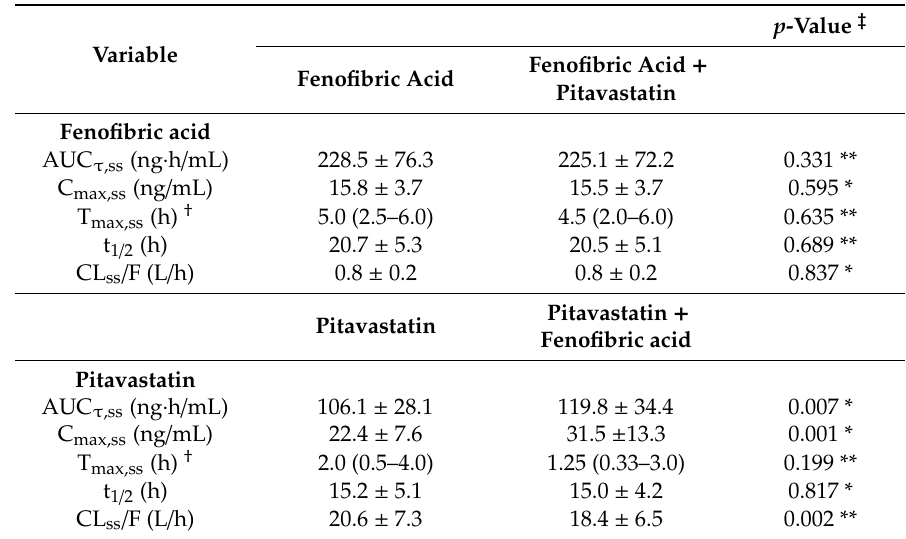
Figure 2. Mean (SD) plasma concentration-time profiles of fenofibric acid ( A ) and pitavastatin ( B ) after multiple oral administration of micronized fenofibrate or pitavastatin alone and co-administration of micronized fenofibrate and pitavastatin. Notes: “0 h” refers to 0 h on day 5 of each period. Table 1. Steady-state pharmacokinetic parameters following administration of micronized fenofibrate (160 mg) and pitavastatin (2 mg) as concomitant administration versus individual administration under fasted conditions in healthy male subjects ( n =